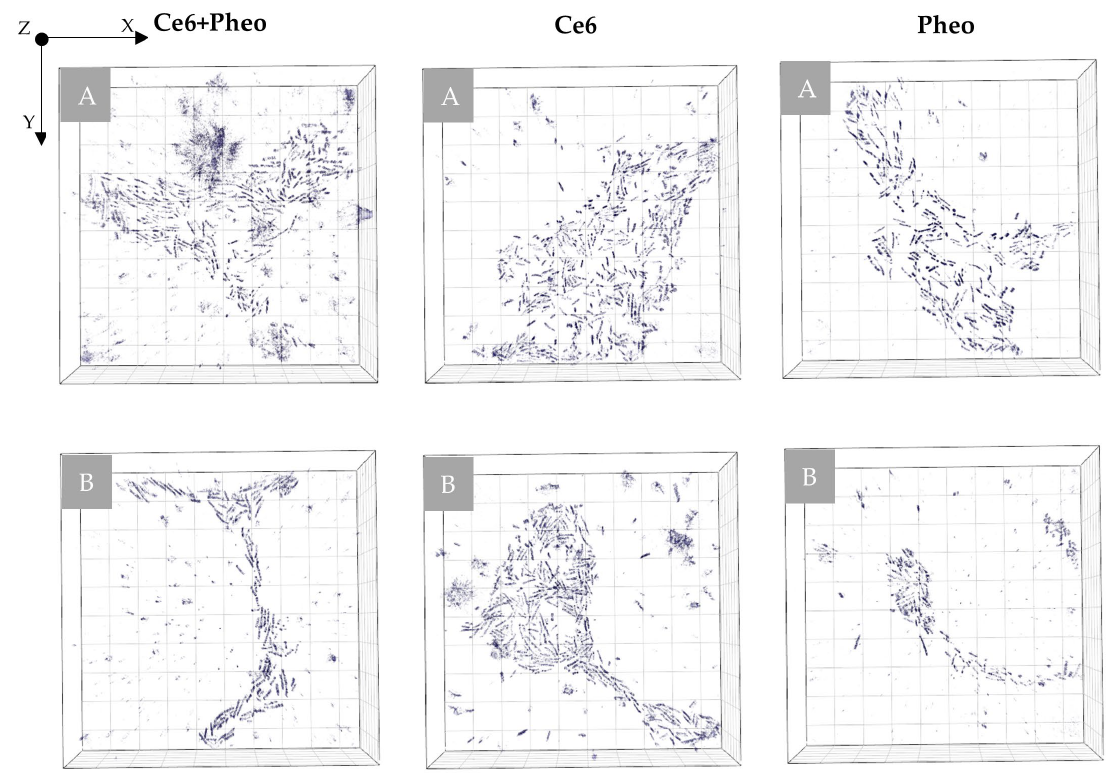
Figure 10. Representative digitally stained (based on the RI values) E. coli cells incubated with photosensitizers before ( A ) and 24 h after irradiation ( B ).